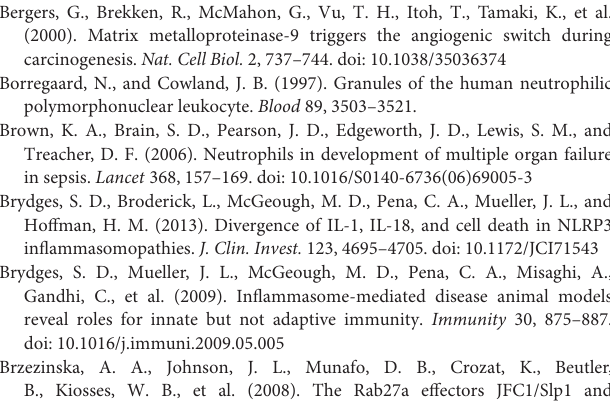
myeloperoxidase (MPO) (A) and gelatinase granule cargo (MMP-9) (B) were analyzed by ELISA in uninduced (pre-Tam) or tamoxifen-induced (post-Tam) MWS ( Nlrp3 mutant) mice as described under “Materials and Methods.” Mean ± SEM, ( n = 3). Unpaired Student’s t -test. Supplementary Figure S3 | Expression levels of Nlrp3 protein in wild type and Nlrp3 A350V MWS mice. Total protein extracts from spleens from 3 wild type and 3 Nlrp3 A350V MWS mice were resolved by gel electrophoresis, transferred to nitrocellulose and analyzed by Western blot. (A) Immunoblot analysisi of NLRP3 expression in three control and three Nlrp3 A350V MWS spleens are shown. (B) Equal loading was determined by Ponceau S staining. (C) Quantitative analysis of normalized protein expression, mean ± SEM, ( n =